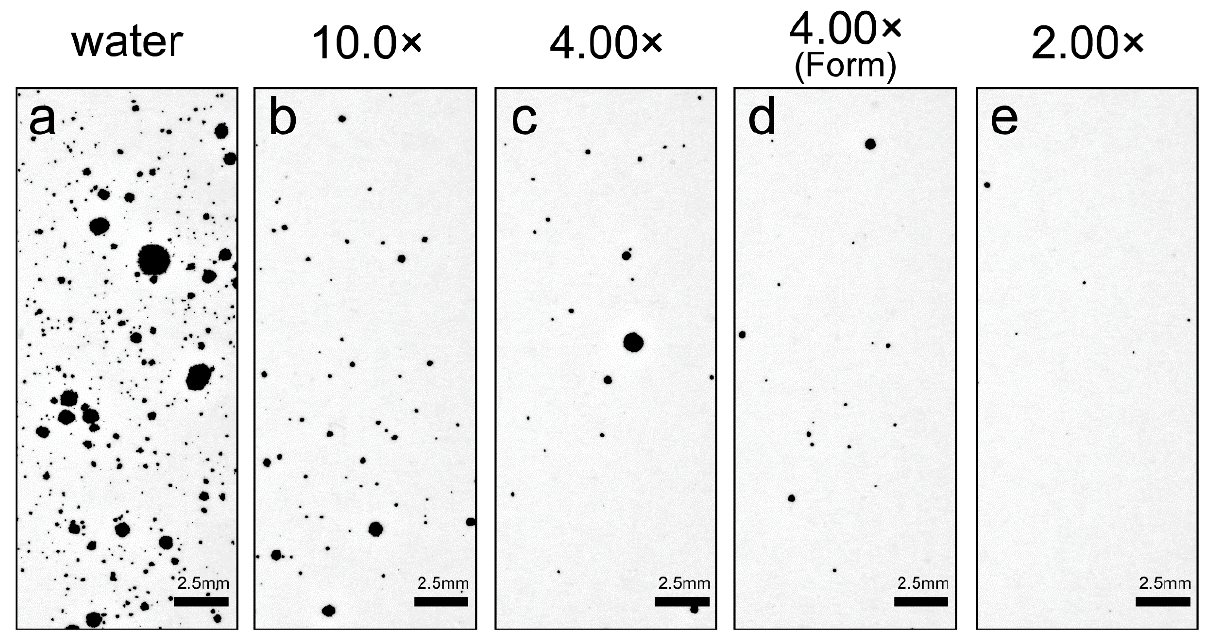
Figure 3. Comparison of droplet properties according to the toothpaste dilution ratio. ( a – e ) Properties of droplet droplets recorded at each toothpaste dilution ratio are shown. The scale bar represents 2.5 mm. It was created from an image in the range of 30 ‒ 40 mm from the droplet generation points on A4-sized inkjet-recording paper. We chose this range setting as within the 0 ‒ 30 mm range, there are many liquid components, the shape of the droplets is unstable, whereas the droplet properties are stable, and the characteristics of each dilution concentration are clearly represented at 30 ‒ 40 mm.